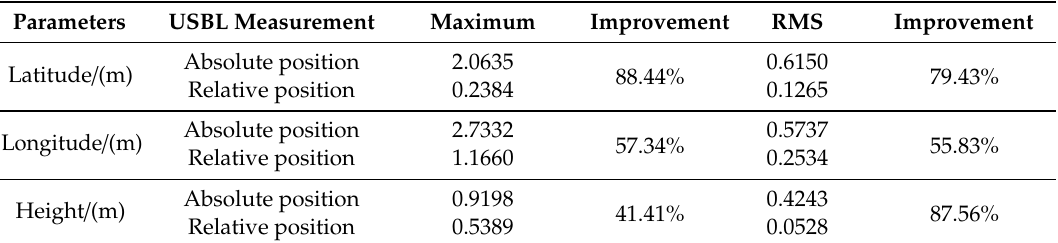
Figure 5. Description of the navigation errors of four algorithms. Table 1. The grid SINS/DVL/USBL integrated navigation position errors.